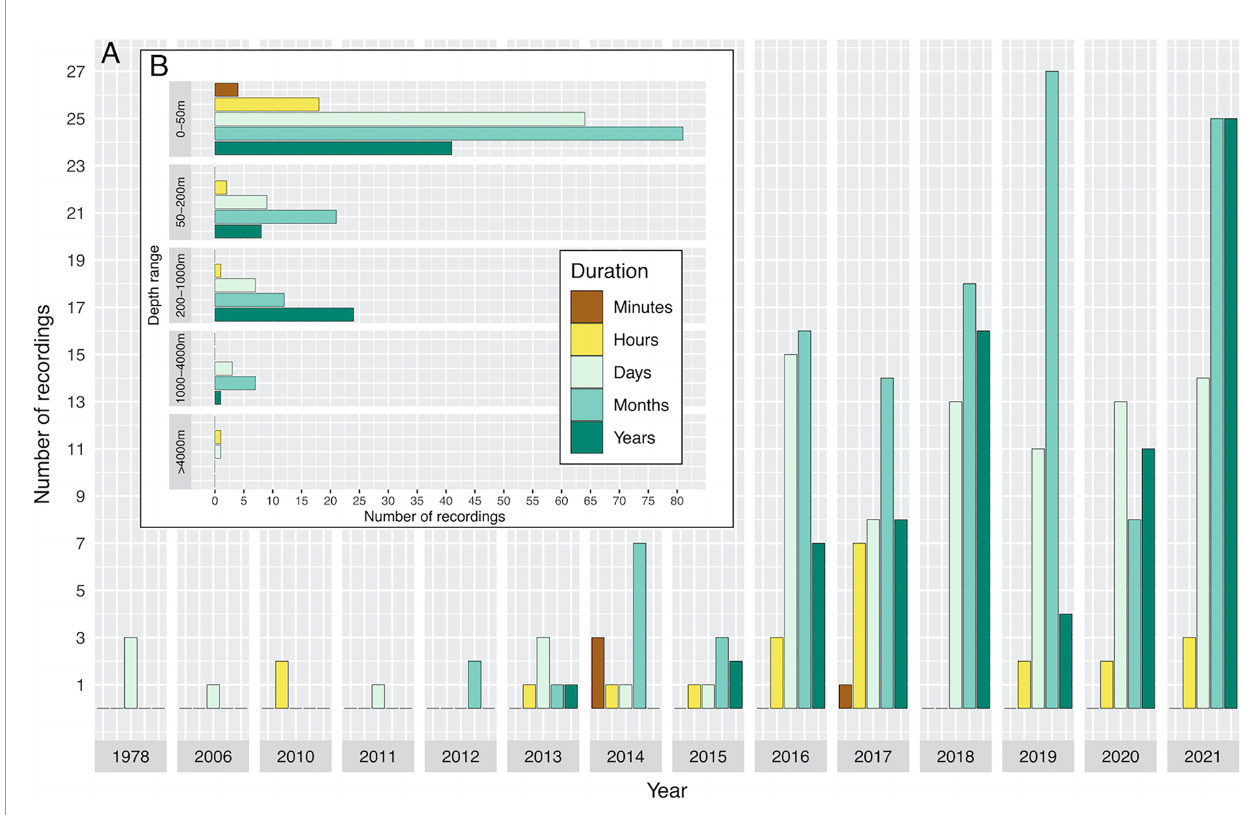
FIGURE 7 | Temporal distribution of the duration of recordings extracted from published studies on ocean soundscapes (see Supplementary Material for data sources) indicating the year in which the study was carried out, and how long the study was undertaken for (A) . (B) shows the depth range of recordings versus the length of time